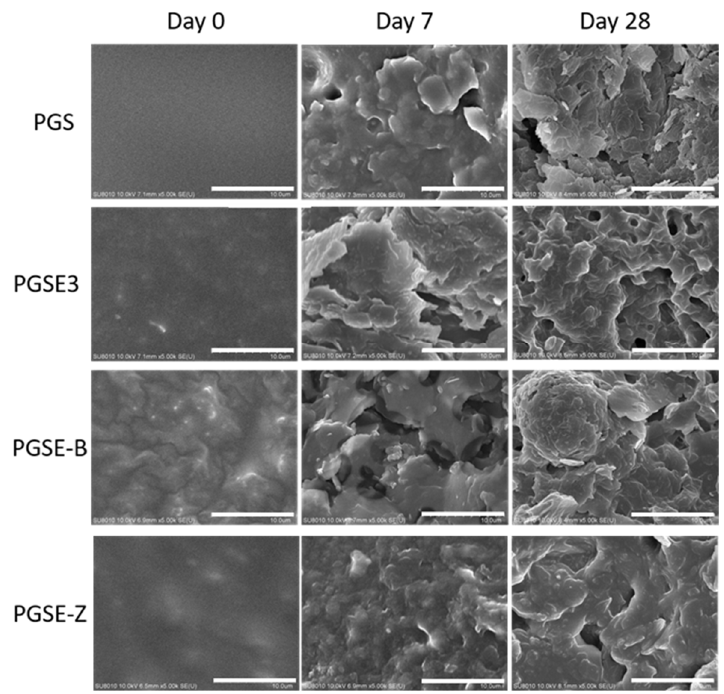
Figure 8. SEM images of surface morphology of PGS, PGSE3, PGSE-B, and PGSE-Z on days zero, seven, and twenty-eight.